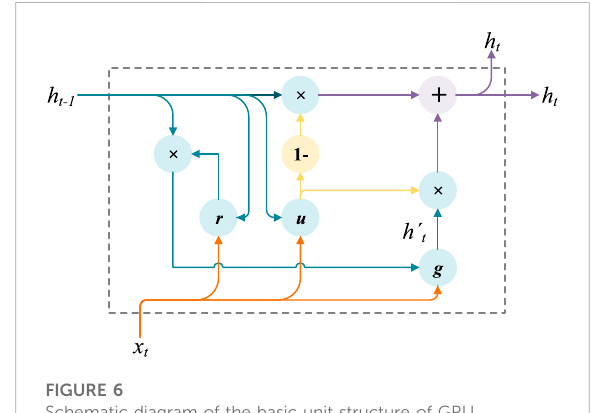
Schematic diagram of the basic unit structure of